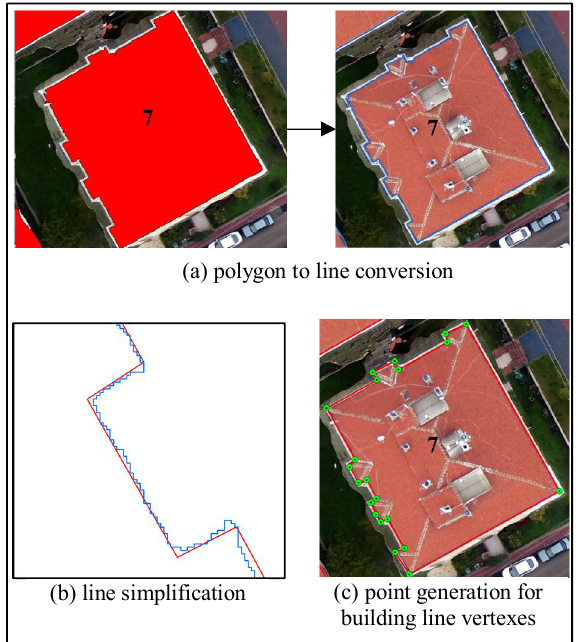
Figure 6. Building height extraction steps from nDSM 4.2.1